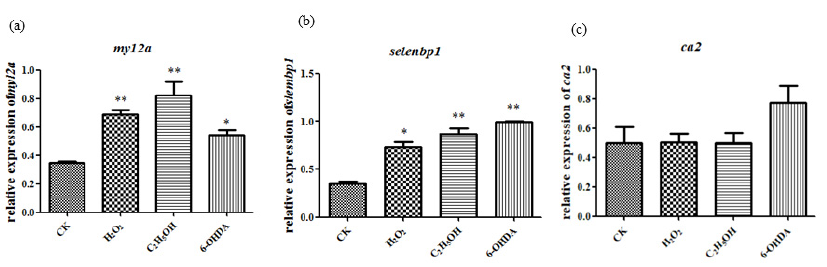
Figure 5. The mortality rate ( a,b )and incubation rate ( c,d ) after being 6-OHDA-treated (at a low concentration, 0–50 μ mol/L).